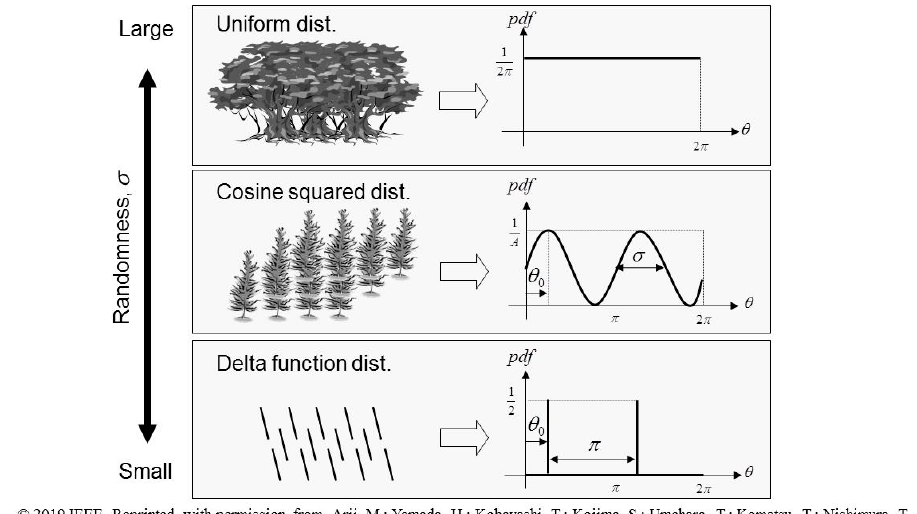
Figure 6. Various probability distribution functions (pdfs) in terms of randomness. There are two extreme cases: Uniform distribution with the highest variance and delta function distribution with the lowest variance. Cosine squared distribution sits in between these two. The randomness is defined by σ as shown in the cosine squared distribution